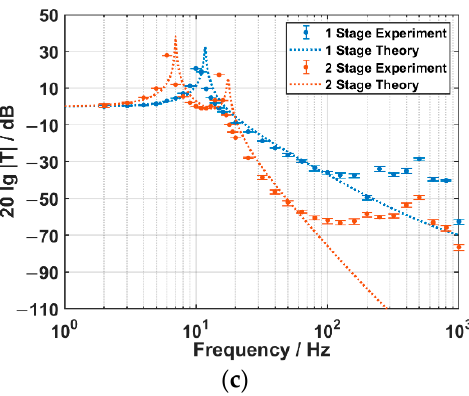
Figure 14. The experimental results of the acceleration transmissibility spectra for two kinds of suspension systems: ( a ) along X direction; ( b ) along Y direction; and ( c ) along Z direction.